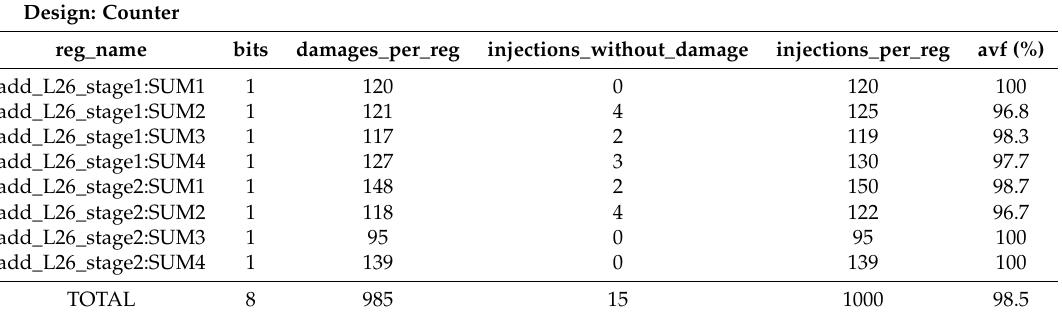
Table 1. Campaign for counter